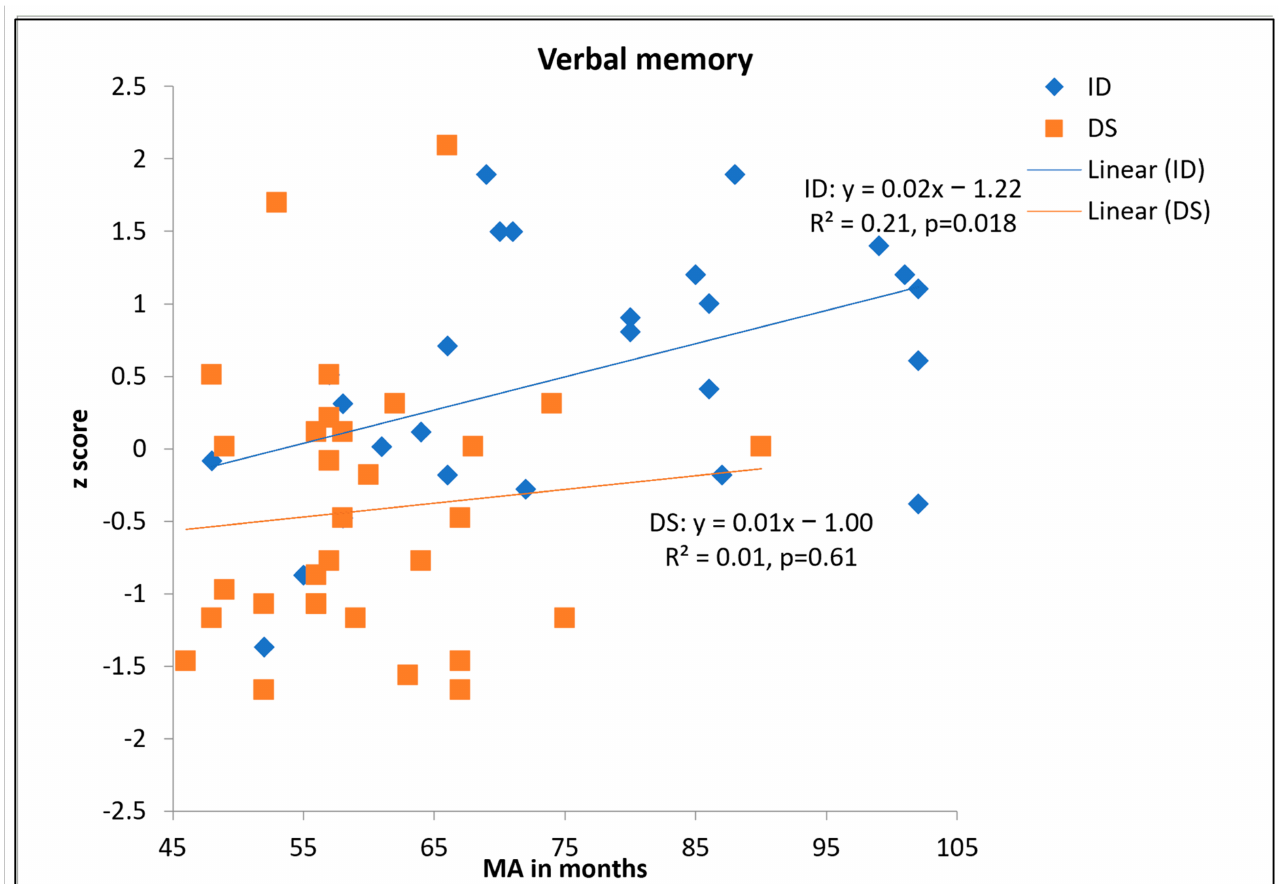
Figure 2. Scatterplot of z scores in verbal memory as a function of